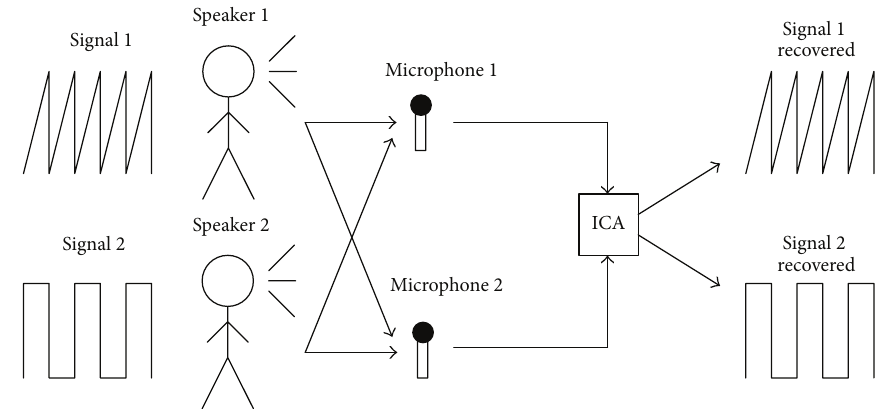
Figure 4: A simple example for understanding the ICA concept [13].